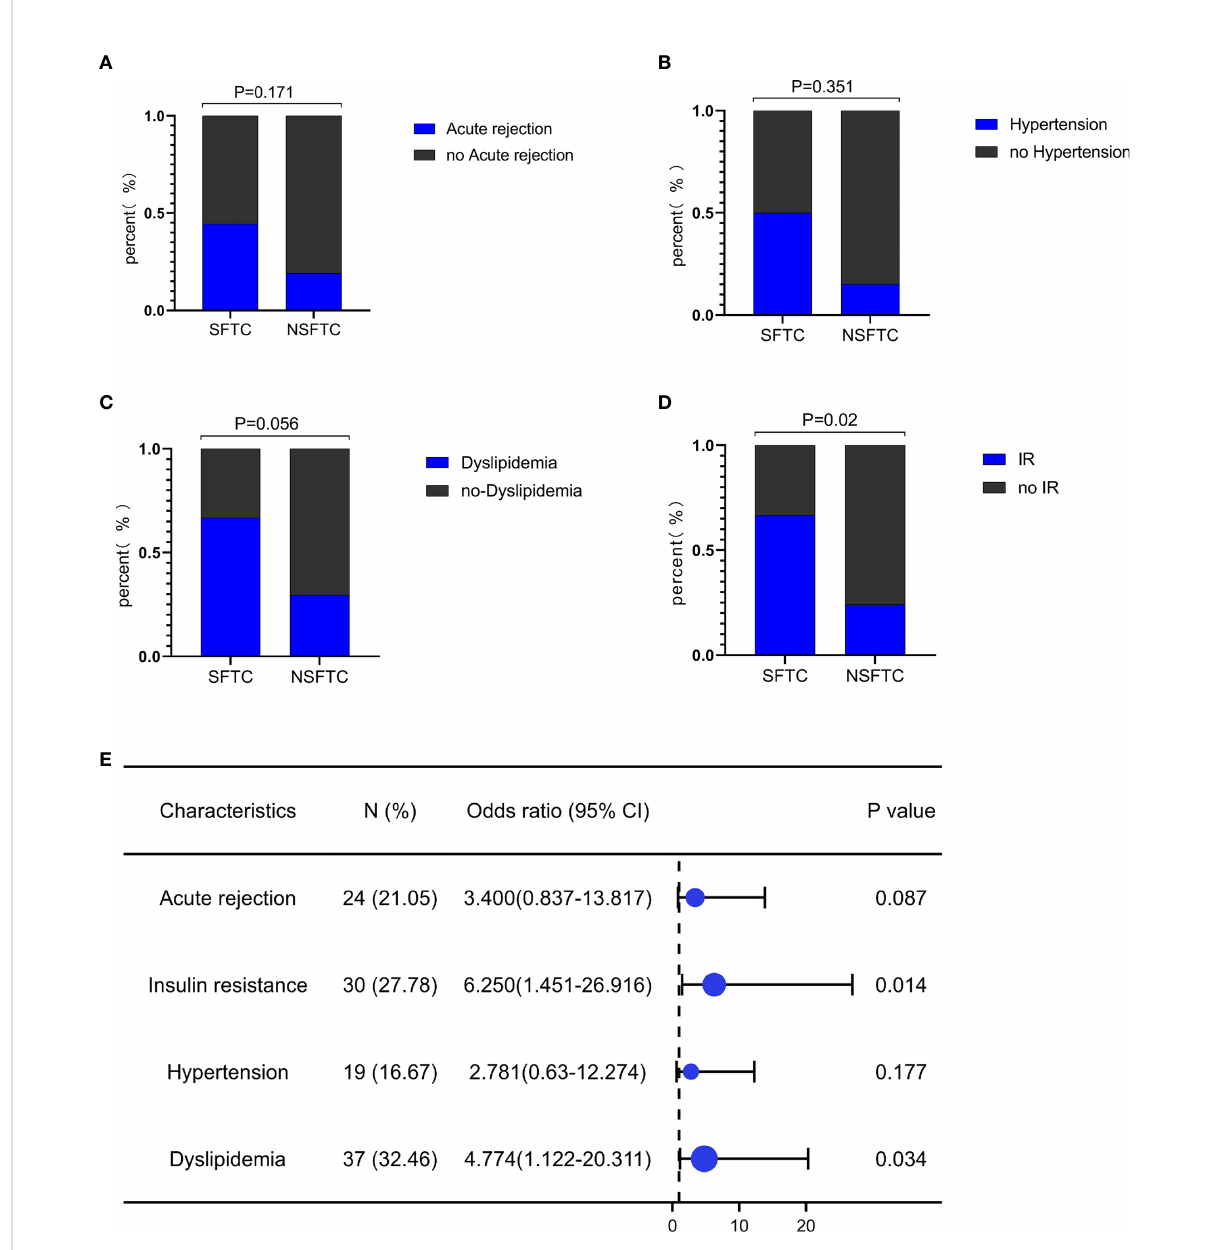
FIGURE 1 Switching from FK506 to cyclosporine (SFTC) associated with the poor prognosis. (A) SFTC increased the incidence of insulin resistance; (B) SFTC might increased the incidence of dyslipidemia; (C) SFTC might increased the incidence of hypertension; (D) SFTC might increased the incidence of acute rejection; (E) The forest plot showed the correlation of SFTC and complications. P less than 0.05 means statistical signi fi